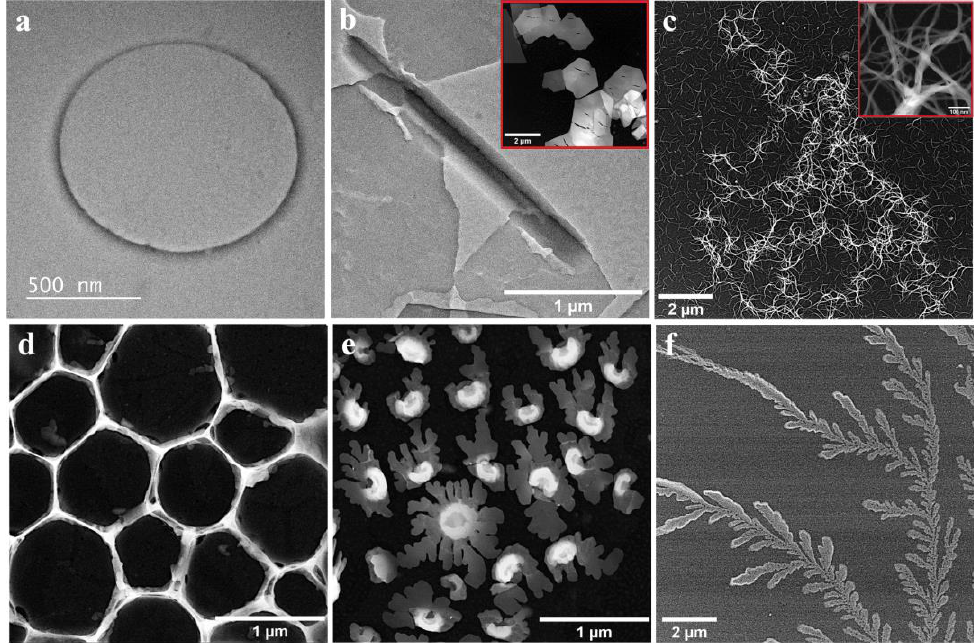
Figure 2. TEM/STEM images recorded for the P3 and P4 porphyrins, drop-casted on TEM grids from solutions obtained using different solvents. The insets present TEM photographs recorded at high magnification